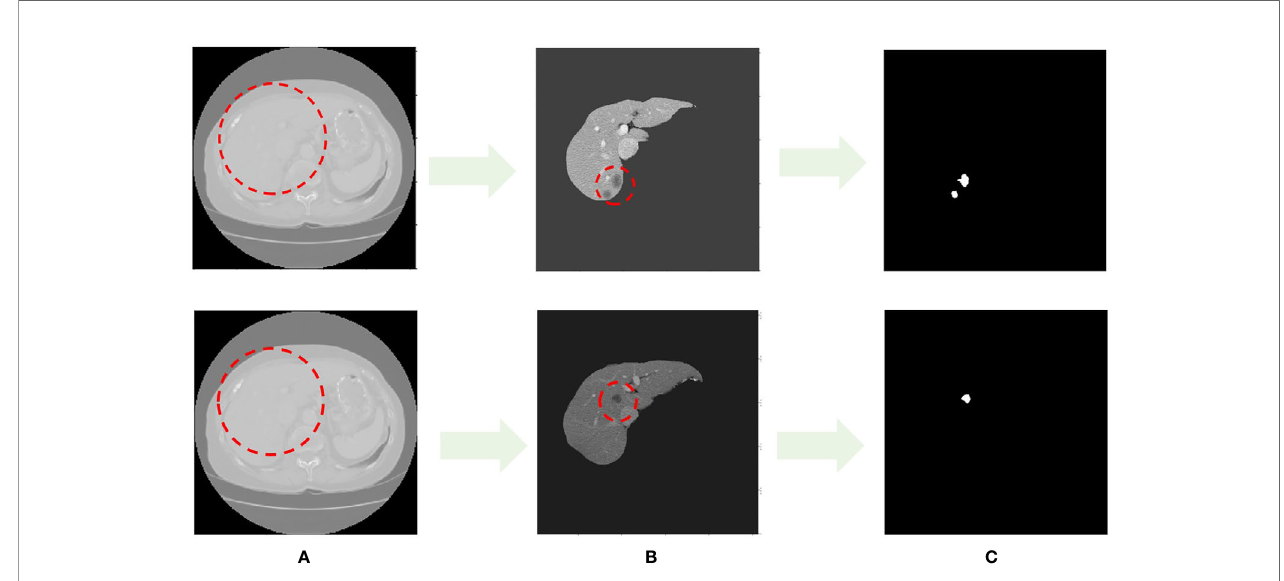
FIGURE 1 | CT image sample with liver and liver tumors. (A) Images in LITS dataset. (B) Liver image. (C) Tumor label.